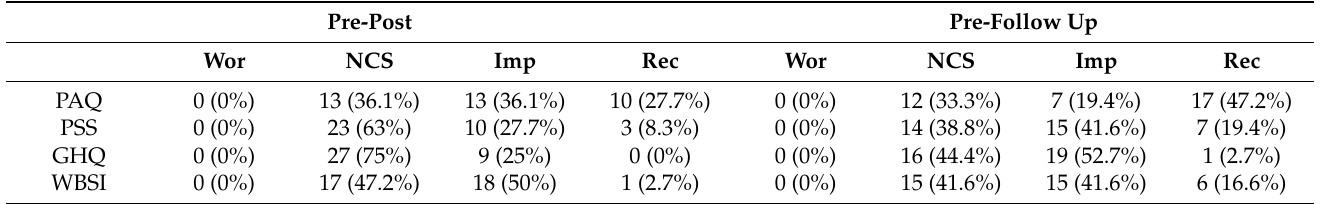
Table 3. Clinical significance of changes observed as a result of the implementation of the intervention programme for n = 36